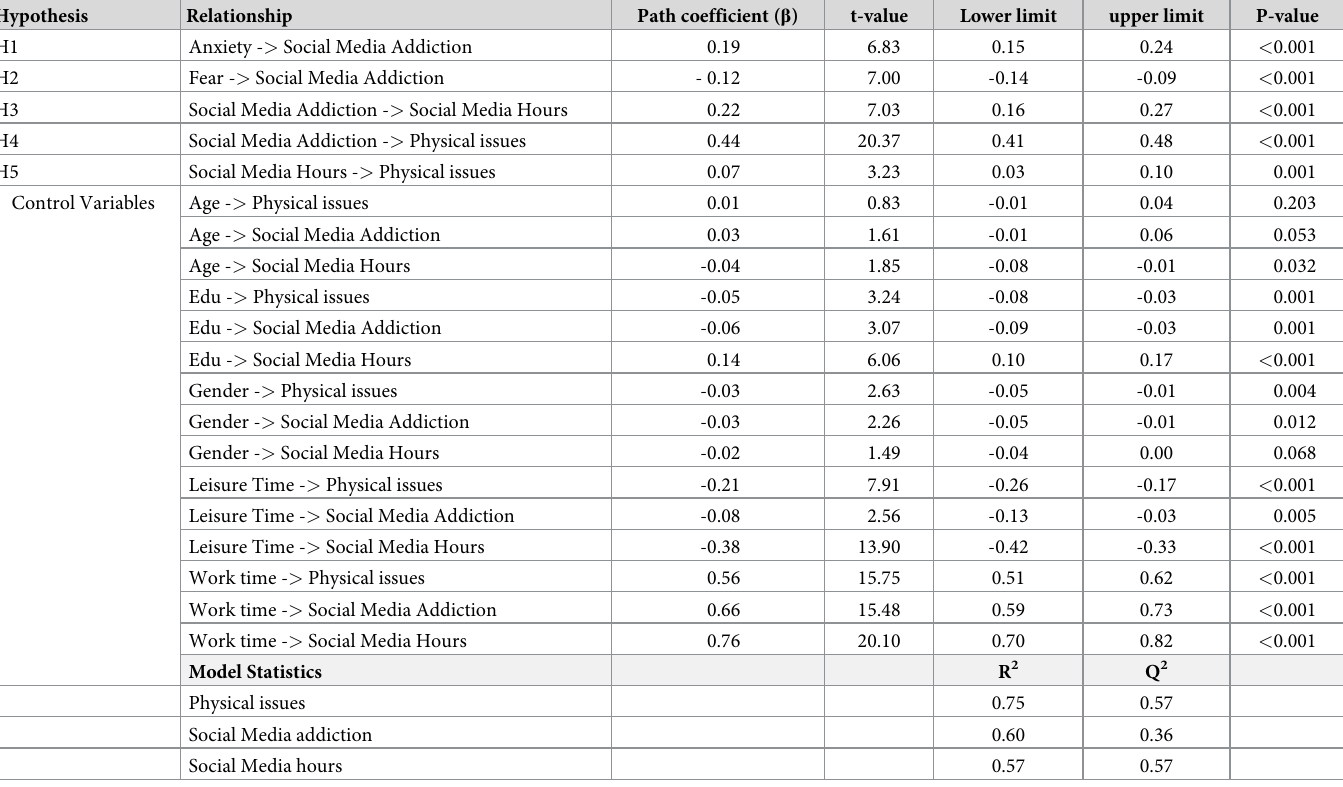
Table 2. Hypothesis testing, path coefficients and their 95% Confidence Intervals